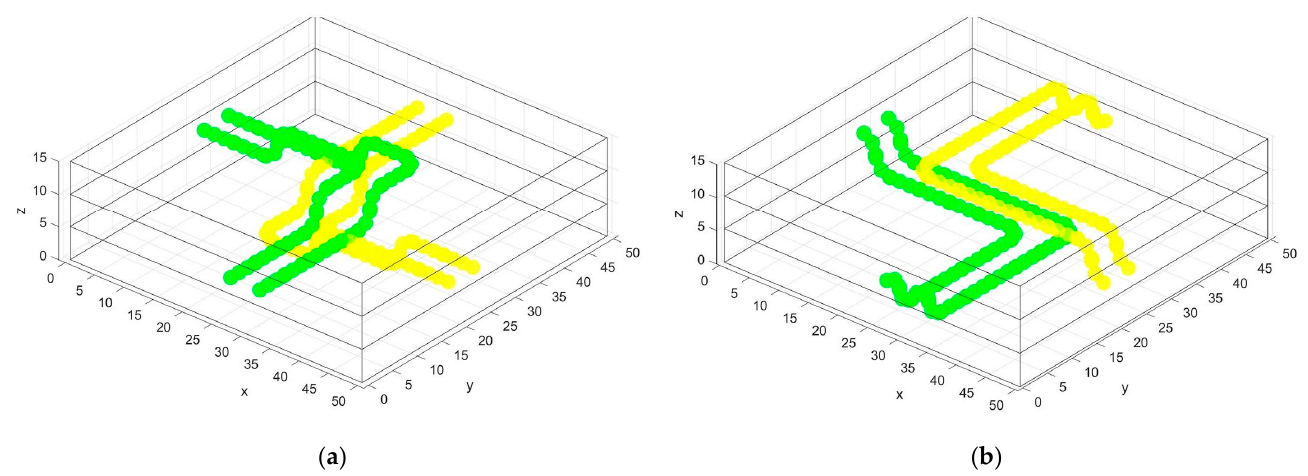
Figure 15. Trajectories of the UAVs scheduled at t i that will change layer in ( a ) mode 1 and ( b ) mode 2. One UAV is represented by one color and UAVs coming from the same way have the same color.